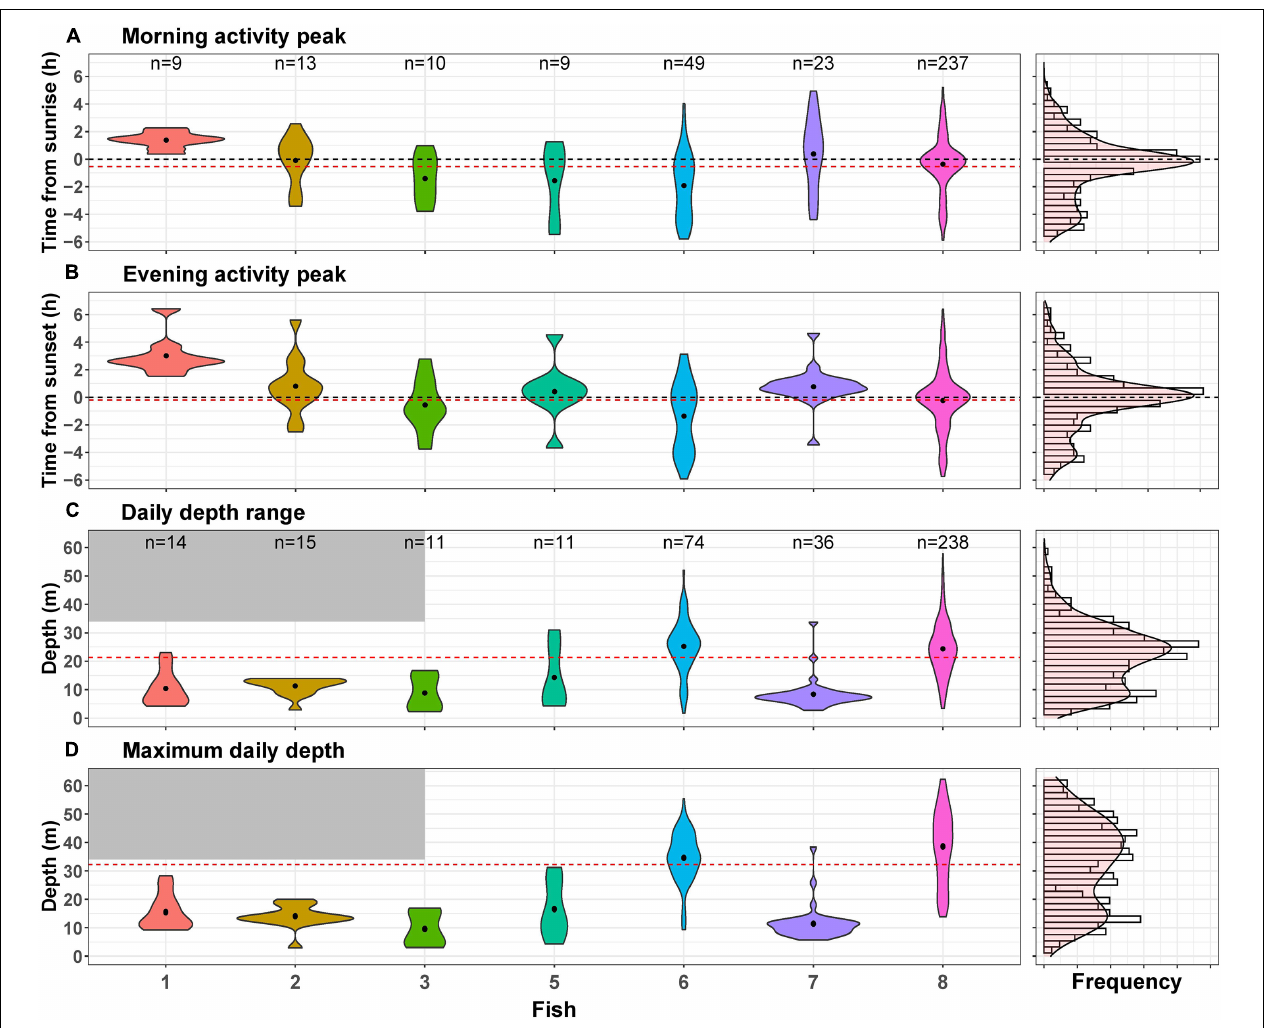
FIGURE 3 | Distribution of the four daily indices across all individuals (right) and separately for each tagged individual (left). Dots in the violin plots represent the mean value for each fish, and the red dashed lines indicate the mean value for all fish. “ n ” represents the number of days used for each violin plot. (A) Morning activity peak, sunrise is denoted by a dashed black line. (B) Evening activity peak, sunset denoted by a dashed black line. (C) Daily depth range and (D) maximum daily depth. The gray shaded areas denote the Vemco transmitter depth limitation.